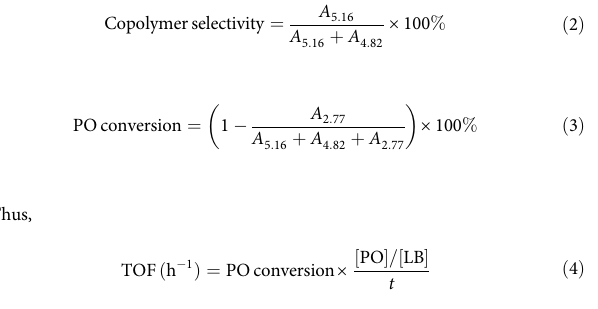
Fig. 27. Tert -butylimino-tris(dimethylamino) phosphorene ( t Bu-P 1 , P1 , 97%), 1- tert- Butyl-2,2,4,4,4-pentakis(dimethylamino)-2 λ 5 , 4 λ 5 -catenadi (phosphazene) ( t Bu-P 2 , P2 , ~2.0 M in THF) and 1- tert- butyl-4,4,4-tris(dimethylamino)-2,2-bis [tris(dimethylamino)- phosphoranylidenamino]-2 λ 5 , 4 λ 5 -catenadi(phosphazene) ( t Bu-P 4 , P4 , ~0.8 M in hexane) were purchased from Sigma and used directly. 1,5,7-Triazabicyclo[4,4,0]dec-5-ene (TBD) was purchased from Aldrich Chemical Co, which were puri fi ed by dissolving in toluene over CaH 2 , fi ltering after stirring overnight, and removing the solvent. Benzyl alcohol (BnOH), N -methyl-1,5,7- triazabicyclododecene (MTBD) and 1,8-diazabicyclo[5,4,0]undec-7-ene (DBU) were purchased from Alfa Aesar Chemical Co. and Aldrich Chemical Co., respectively, which were puri fi ed by distillation over distillation over CaH 2 and stored in an inert gas (N 2 )- fi lled glove box. Sodium hydride (95%) was purchased from Sigma and used directly. Carbonyl sul fi de (COS) (99.9%) was purchased from the APK (shanghai) Gas Company LTD and used as received.